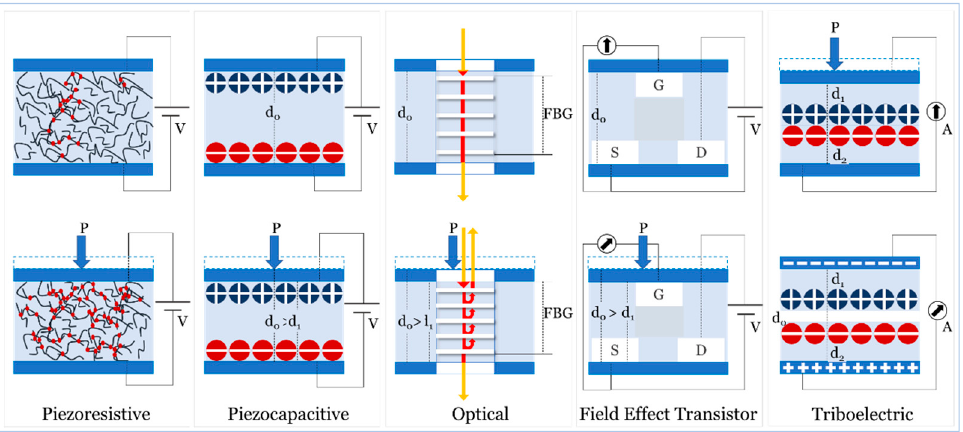
Figure 6. Fundamental sensing principles used in sensors.